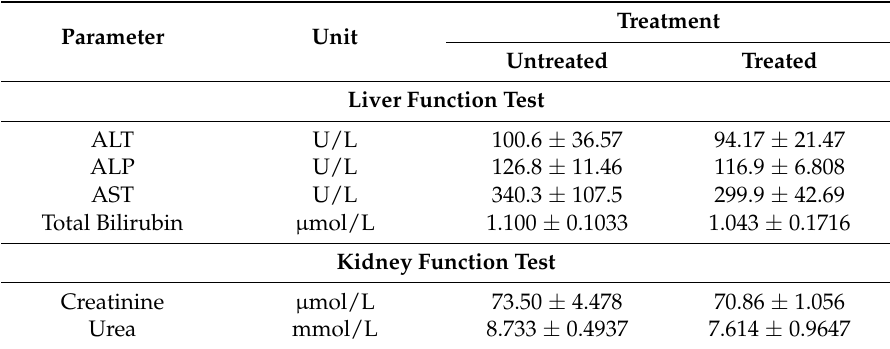
Table 2. Biochemical analysis on the acute oral toxicity effect of Clinacanthus nutans water leaf extract in Sprague Dawley